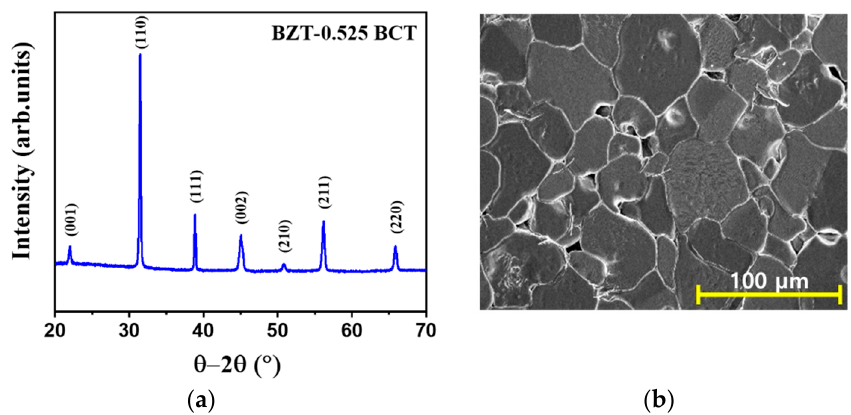
Figure 2. ( a ) XRD pattern and ( b ) FE–SEM image of the BZT–BCT ceramics.